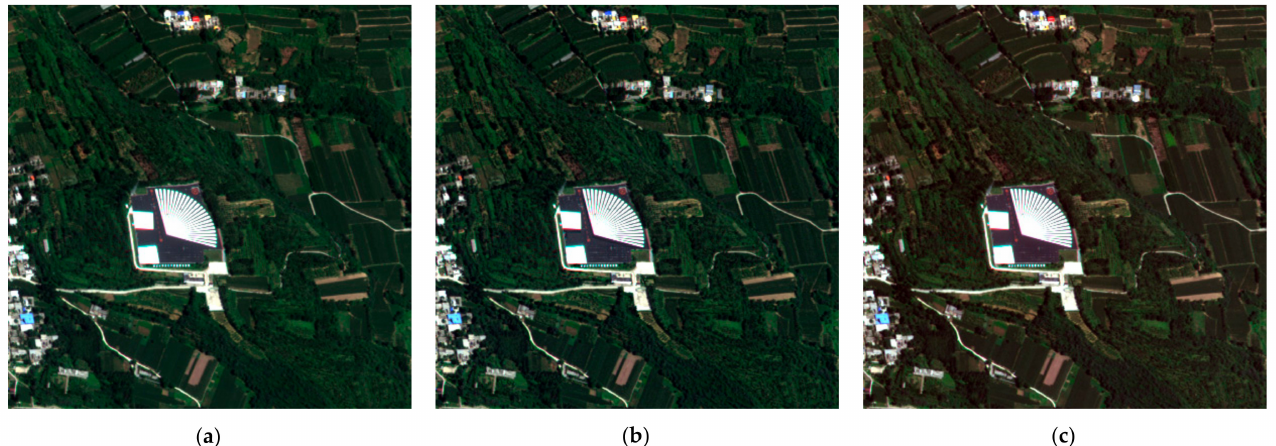
Figure 10. Images of Songshan on 26 August 2020. ( a ) Original image; ( b ) corrected image after Syn-AC; ( c ) corrected image after FLAASH. The retrieved AOD at 550 nm and retrieved CWV are 0.225 and 2.42 g/cm 2 ,